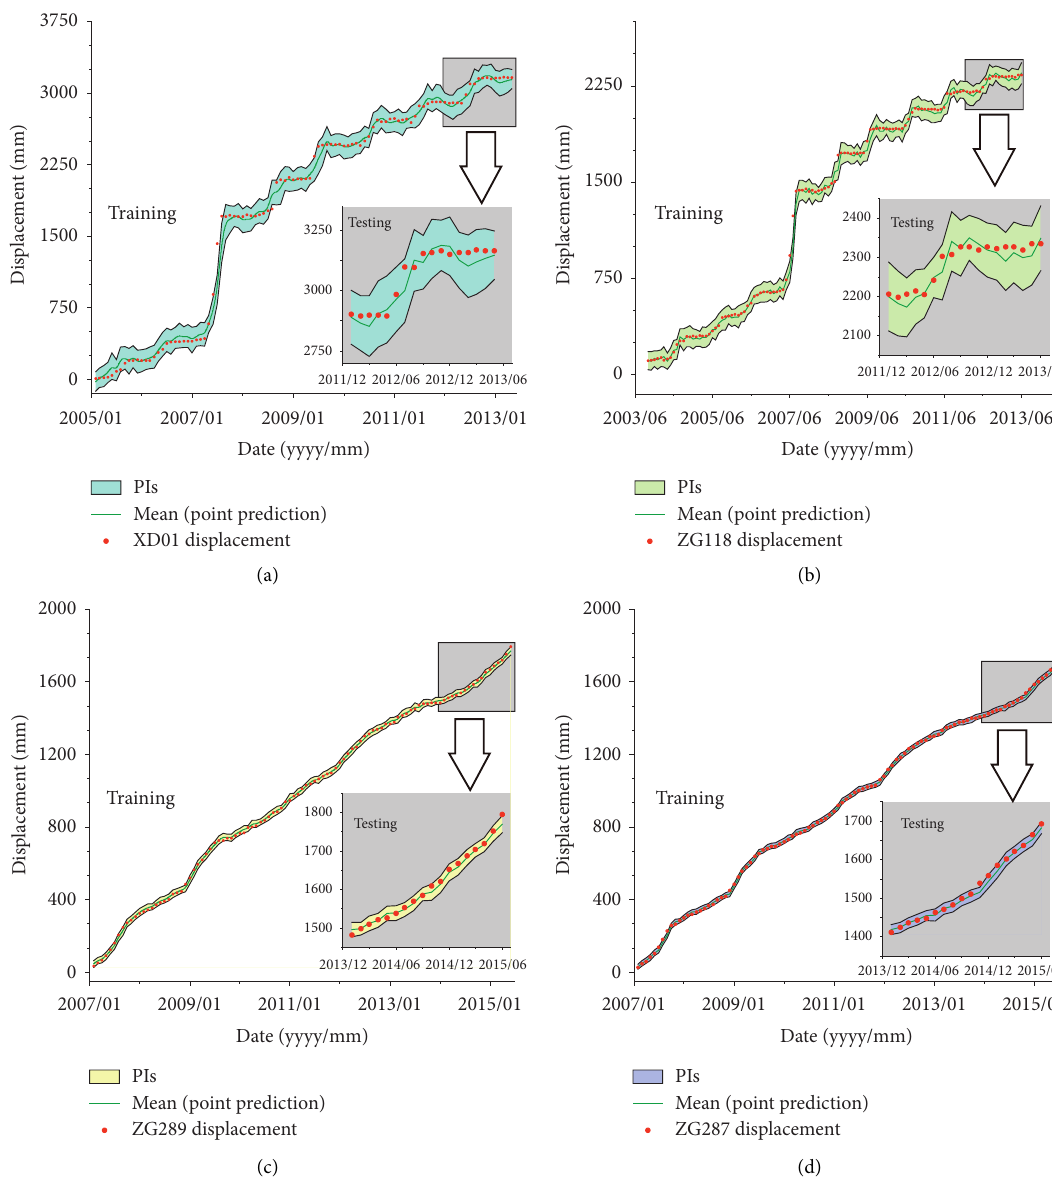
Figure 11: Constructed PIs with 95% confidence levels: (a) XD01 of the Baishuihe landslide; (b) ZG118 of the Baishuihe landslide; (c) ZG289 of the Tanjiahe landslide; (d) ZG287 of the Tanjiahe